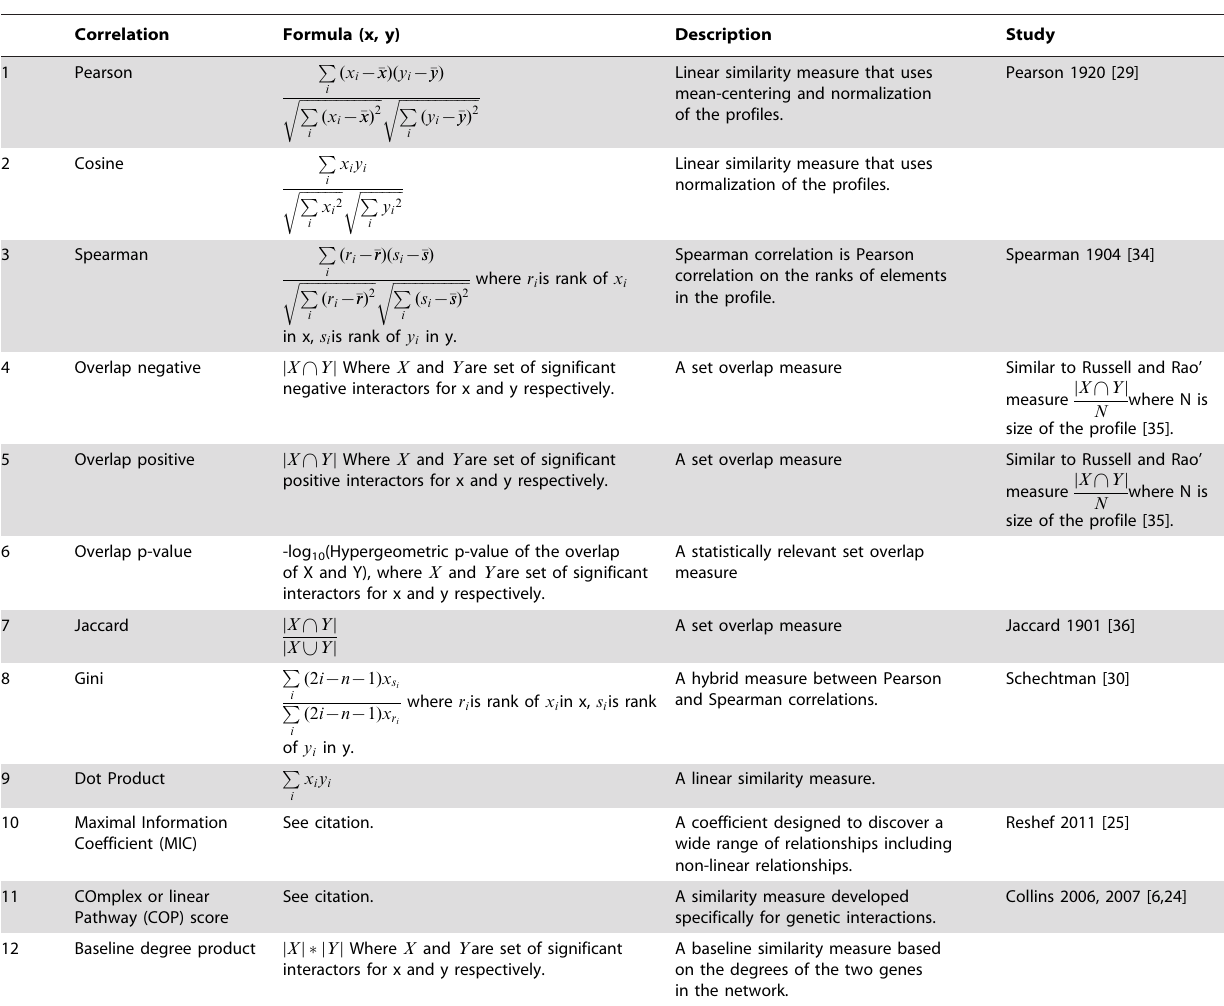
Table 1. Similarity measures evaluated in this